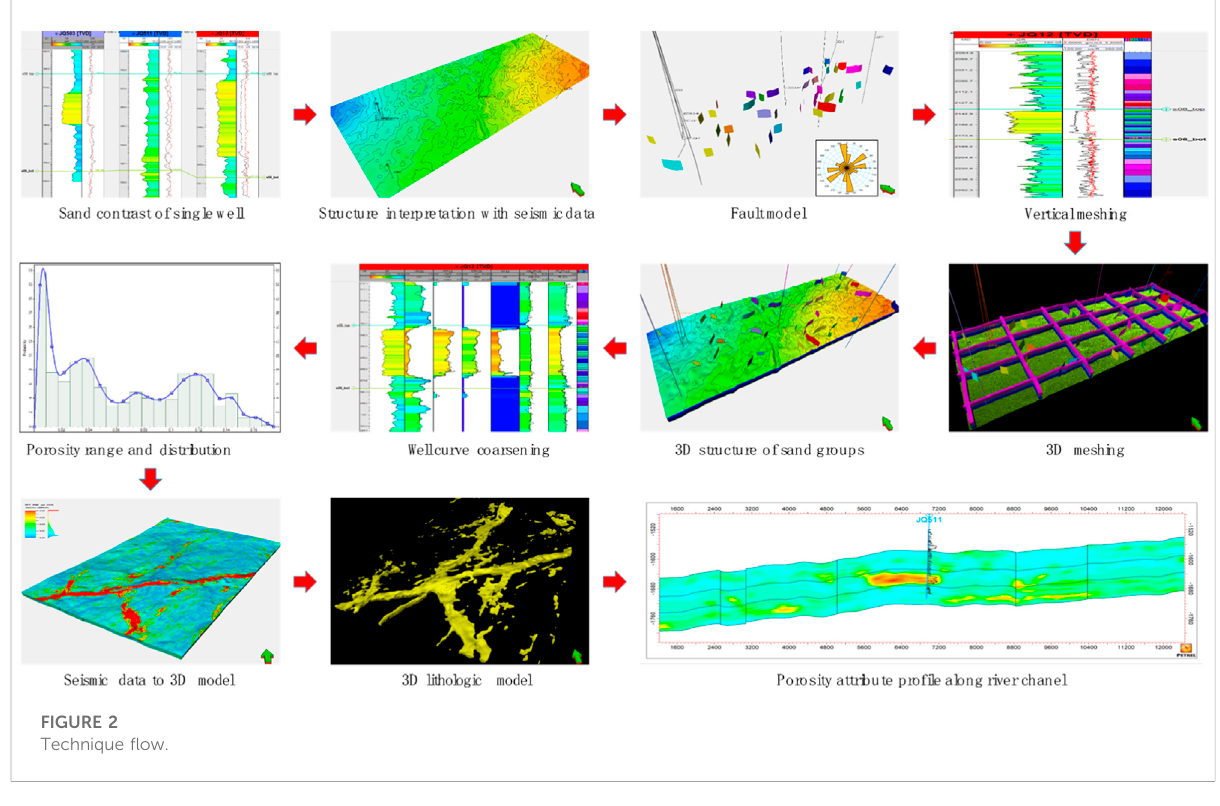
FIGURE 2 Technique fl ow.